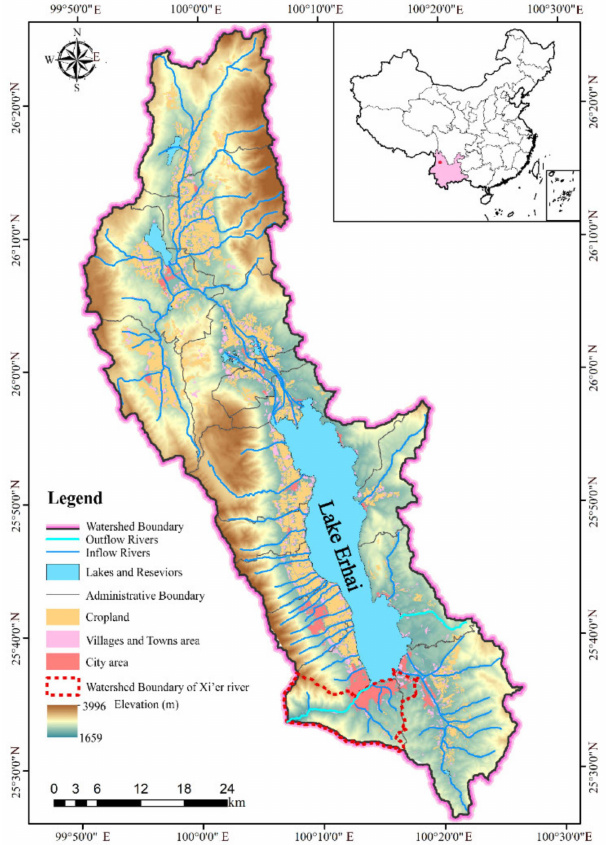
Figure 1. Location and map of Lake Erhai watershed, the two outflows are marked with light blue. The Xi’er river watershed in the southeast of the lake is circled with red dotted line, the natural runoff in this area do not flow into the